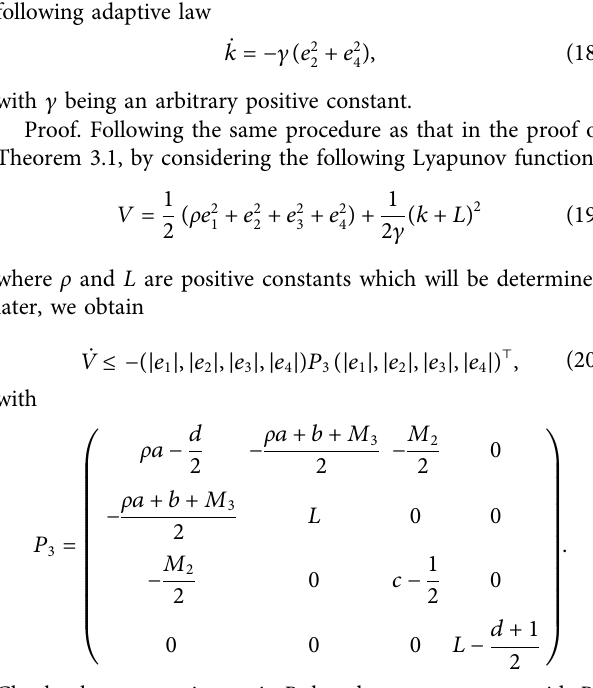
Frontiers in Physics |